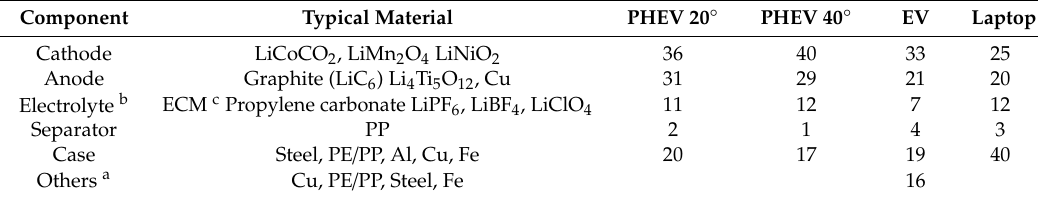
Table 3. Composition of leading Li-ion batteries